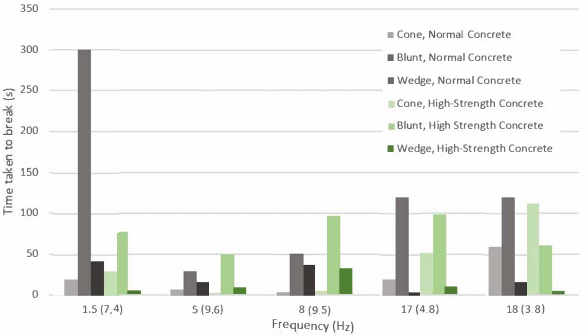
Figure 20. Dependence of time to break on impacts frequency (Mayer